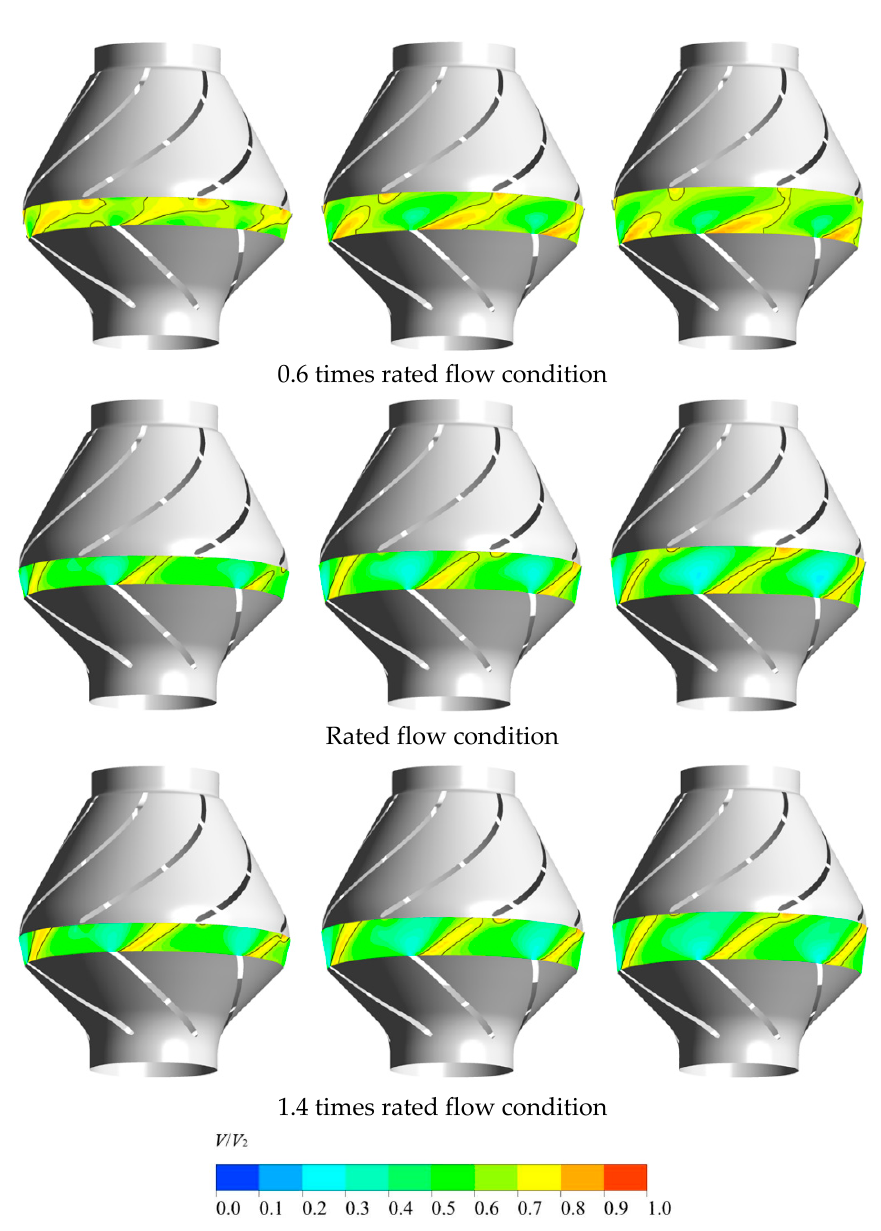
Figure 9. Velocity distribution at mid-span position within the chamber: rotor–stator distance = 1.5 mm; rotor–stator distance = 4.5 mm; rotor–stator distance = 7.5 mm.